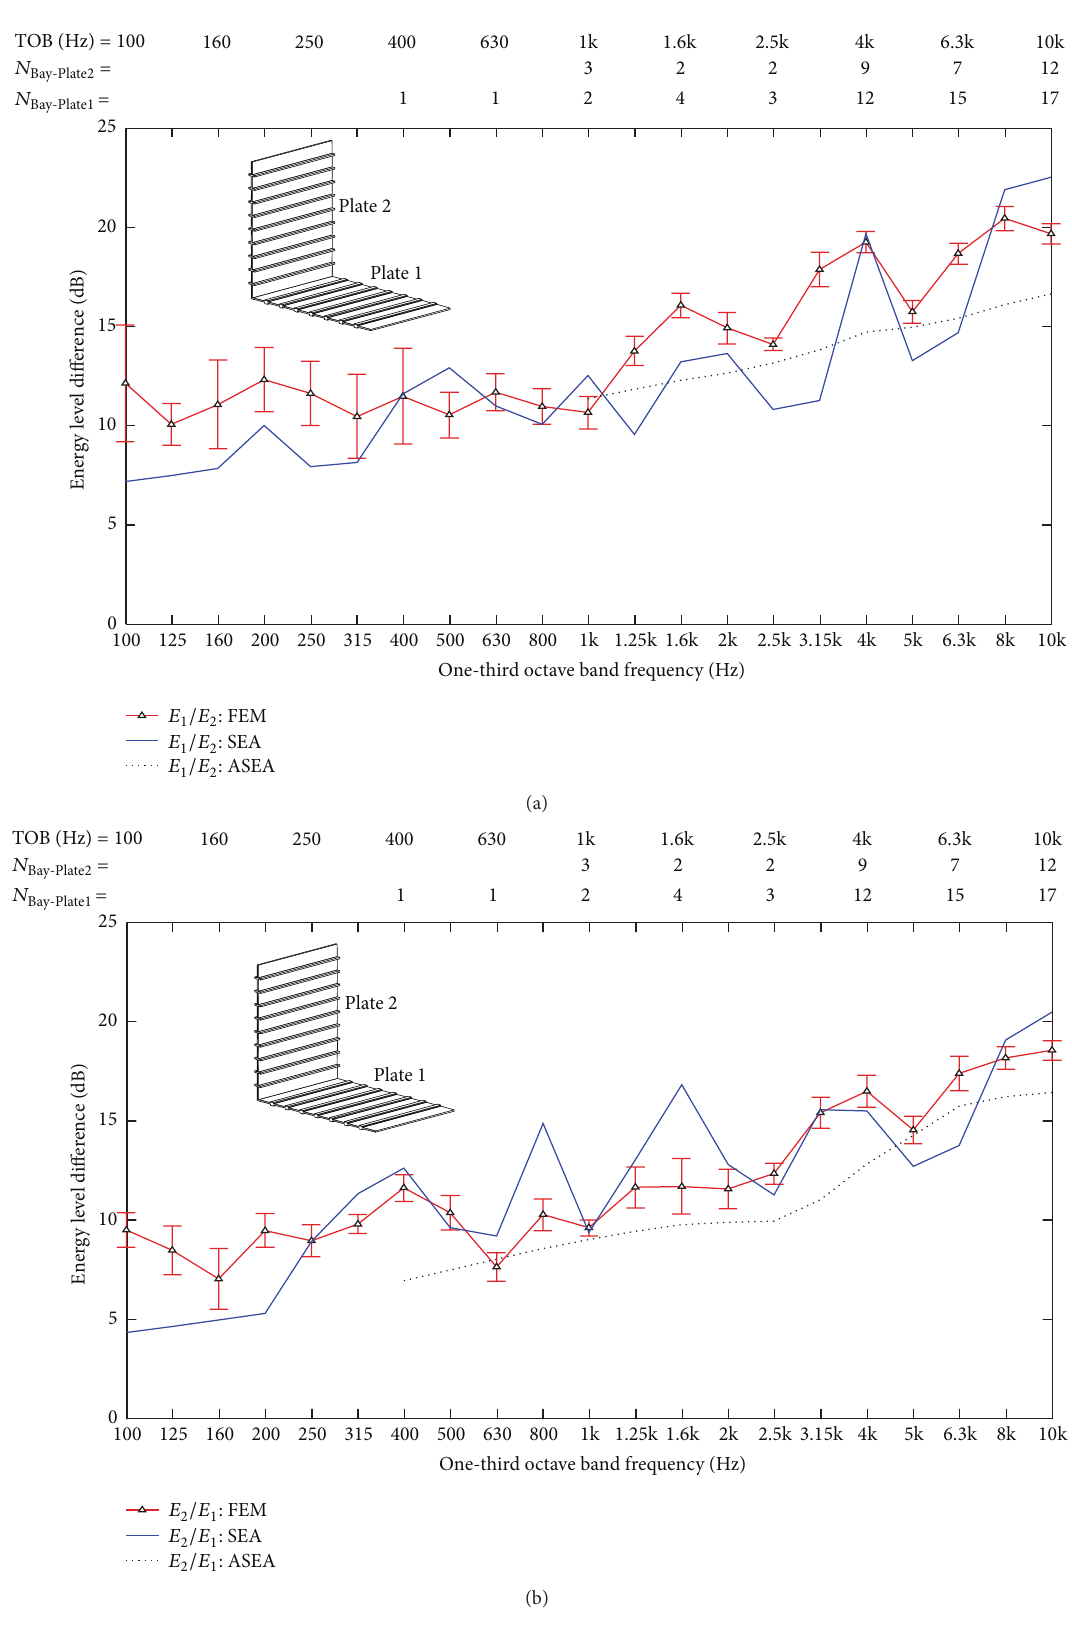
Figure 10: L-junction B. Energy level differences between the isotropic, homogeneous plate (Plate 1) and the periodic ribbed plate (Plate 2) with excitation of (a) Plate 1 and (b) Plate